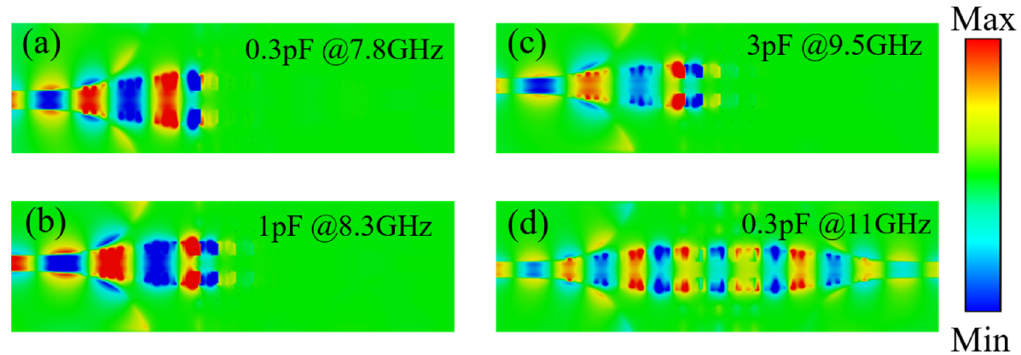
Figure 5. The simulated near-field distribution of the device at ( a ) 7.8 GHz with capacitance 3 pF, ( b ) 8.3 GHz with capacitance 1 pF, ( c ) 9.5 GHz with capacitance 0.3 pF, ( d ) 11 GHz with capacitance 0.3 pF.